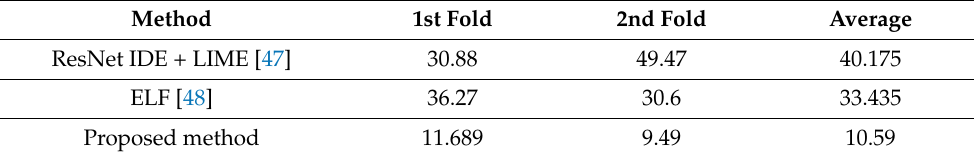
Table 17. Comparisons of EERs obtained using proposed method and state-of-the-art body and face recognition techniques (unit: